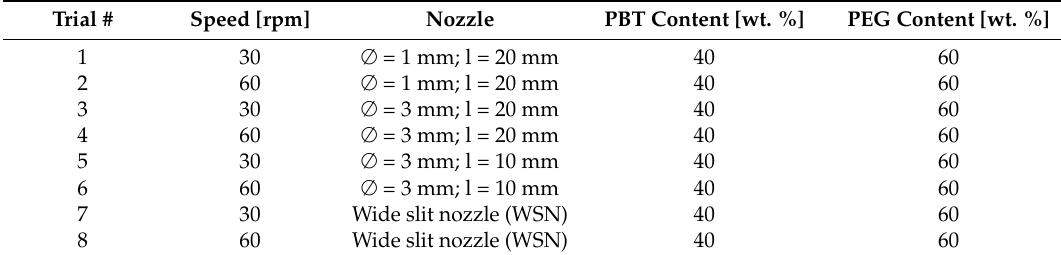
Table 2. Extruder settings for selected extrusion trials. PBT: polybutylene terephthalate; PEG: polyethylene